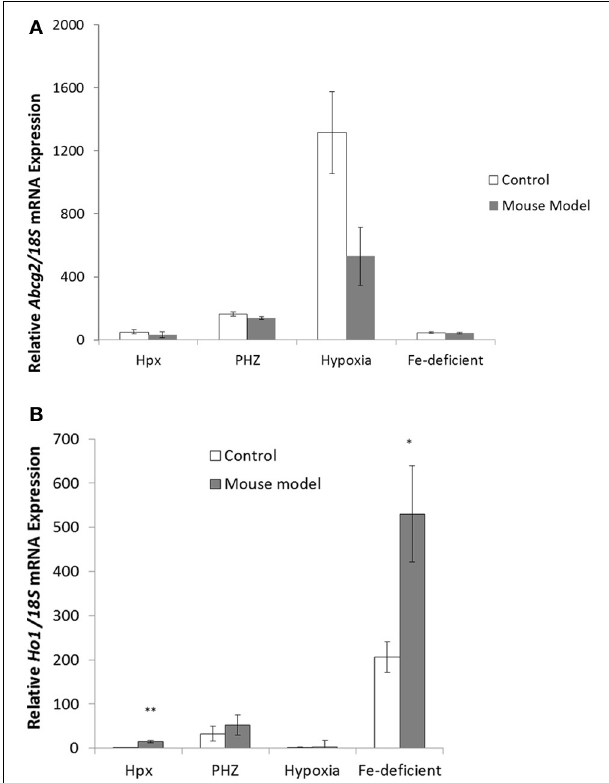
FIGURE 5 | Quantitative Real-Time PCR of Abcg2 and Ho1 mRNA levels in the kidney tissue samples from mouse models with enhanced erythropoiesis. (A) Abcg2 mRNA levels in the kidney of Hpx, PHZ-treated, hypoxic, and iron-deficient mice. Data are mean ± s.e.m. of four observations in each group and are expressed as a ratio of 18S mRNA in arbitrary units. (B) Ho1 mRNA levels in the kidney of Hpx, PHZ-treated, hypoxic, and iron-deficient mice. Data are mean ± s.e.m. of four observations in each group and are expressed as a ratio of 18S mRNA in arbitrary units. Analysis by Students’ T -test showed significant effects of HO-1 mRNA levels in Hpx ( P < 0 . 01), and iron-deficient spleen tissues, ( P < 0 . 01) over the control